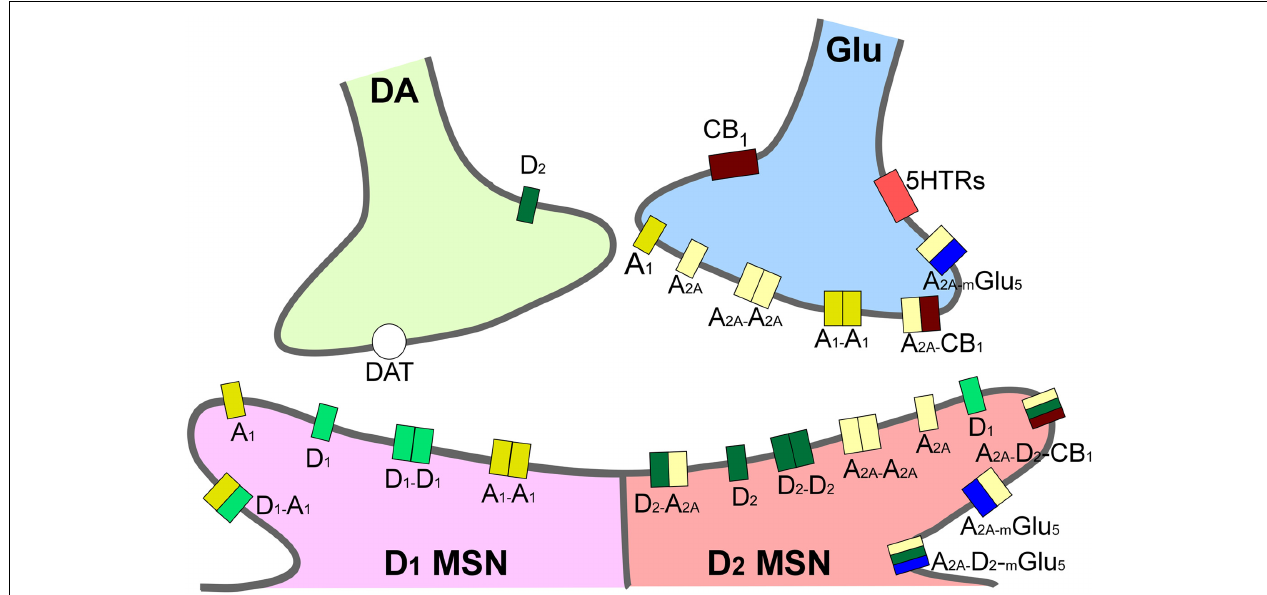
FIGURE 2 | Integrative scheme of reward circuit in striatum with focus on adenosine and dopamine receptors and their interactions. A 1 and A 2A receptors are located pre- and post-synaptically forming homo-, heterodimers and oligomers in the dendritic spines of medium spiny neurons in striatum (MSN). Glutamatergic input from cortex and dopaminergic input from ventral tegmental area project to both MSNs expressing D 1 -like and MSNs expressing D 2 -like dopamine receptors. A 2A , adenosine 2A receptors; CB 1 , endocannabinoid CB 1 receptors; DAT, dopamine active transporters; D 1 , dopamine D 1 receptors; D 2 , dopamine D 2 receptors; mGlu 5 , metabotropic glutamate subtype 5 receptors; 5HTRs, serotonin